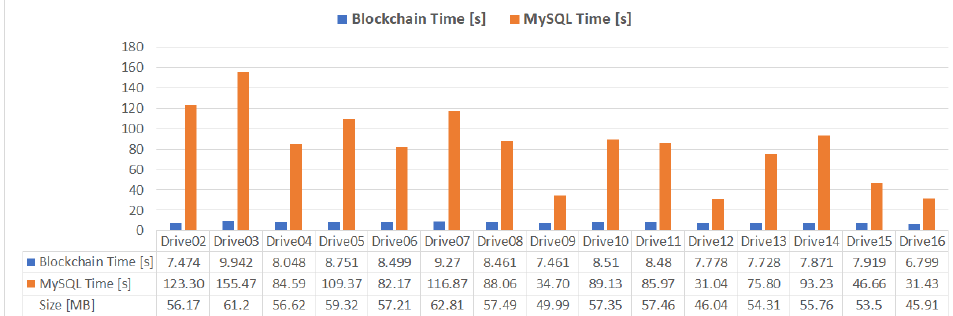
Figure 9. Blockchain and MySQL write times.